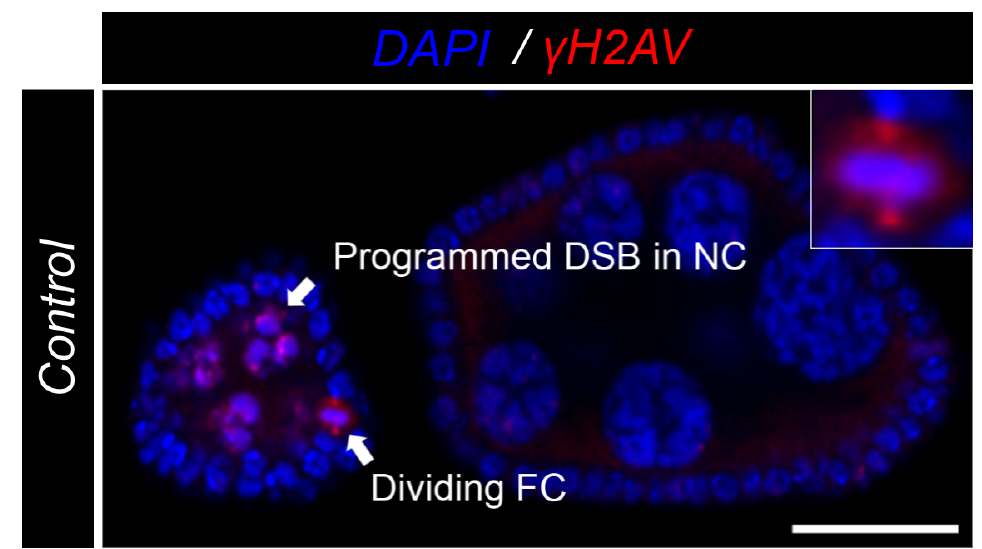
Figure A5. Control γ -H2AV signal in germline and dividing cells. Control egg chamber highlighting the expected double stranded break (DSB) of marked by γ -H2AV antibody in red (DNA) in the nurse cells in early egg chambers. Additional signal is observed in spindles and centrosomes of dividing cells. A subset of a dividing cell is present in the upper right corner. DAPI marks nuclei in blue. Scale bar = 20 µ m.